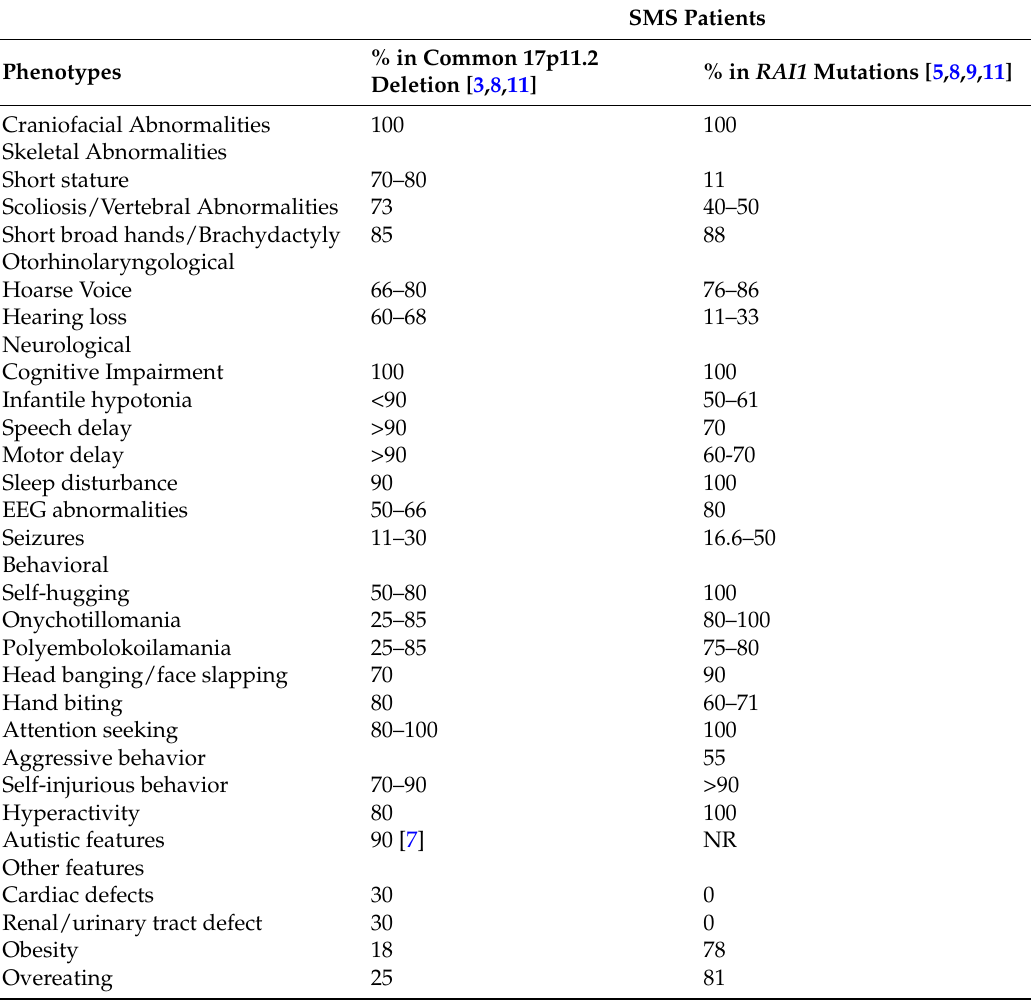
Table 1. Comparison of the clinical presentation of SMS patients with common deletion and RAI1